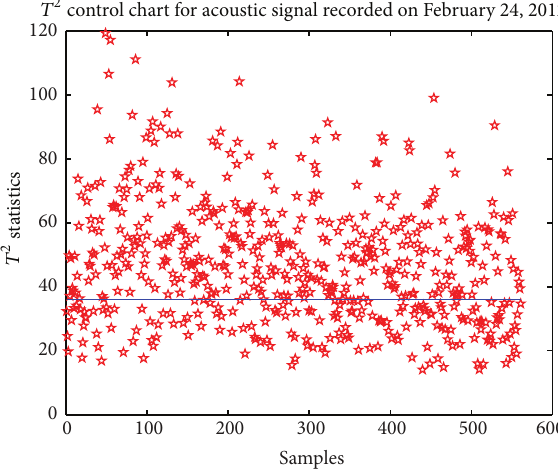
Figure 5: 𝑇 2 control chart for acoustic signal recorded two weeks after grinding table replacement.